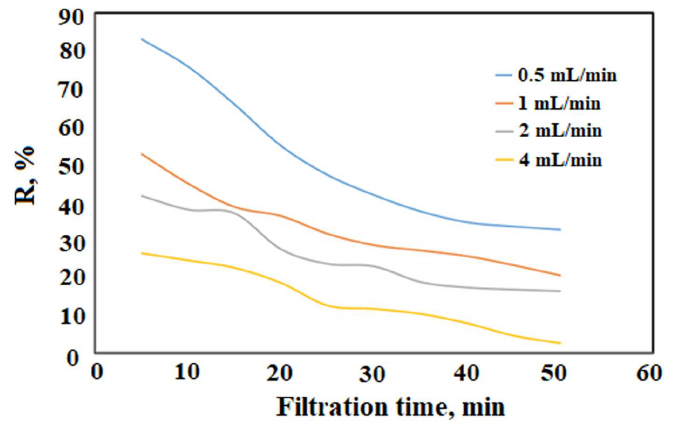
Figure 9. The filtration efficiency of the PIM-Am15 in the treatment process of water with Cd(II) ion content at different volume